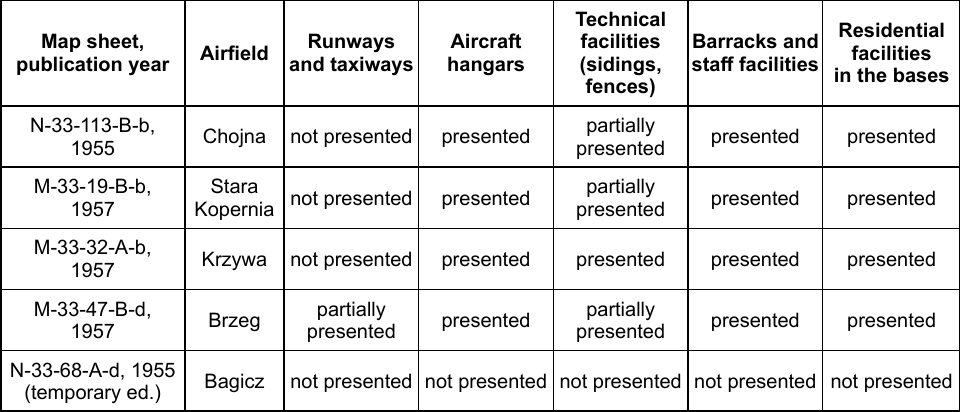
Table 1. List of the contents of the maps of the “General Staff” edition concerning the most important Soviet military air bases Map sheet, publication